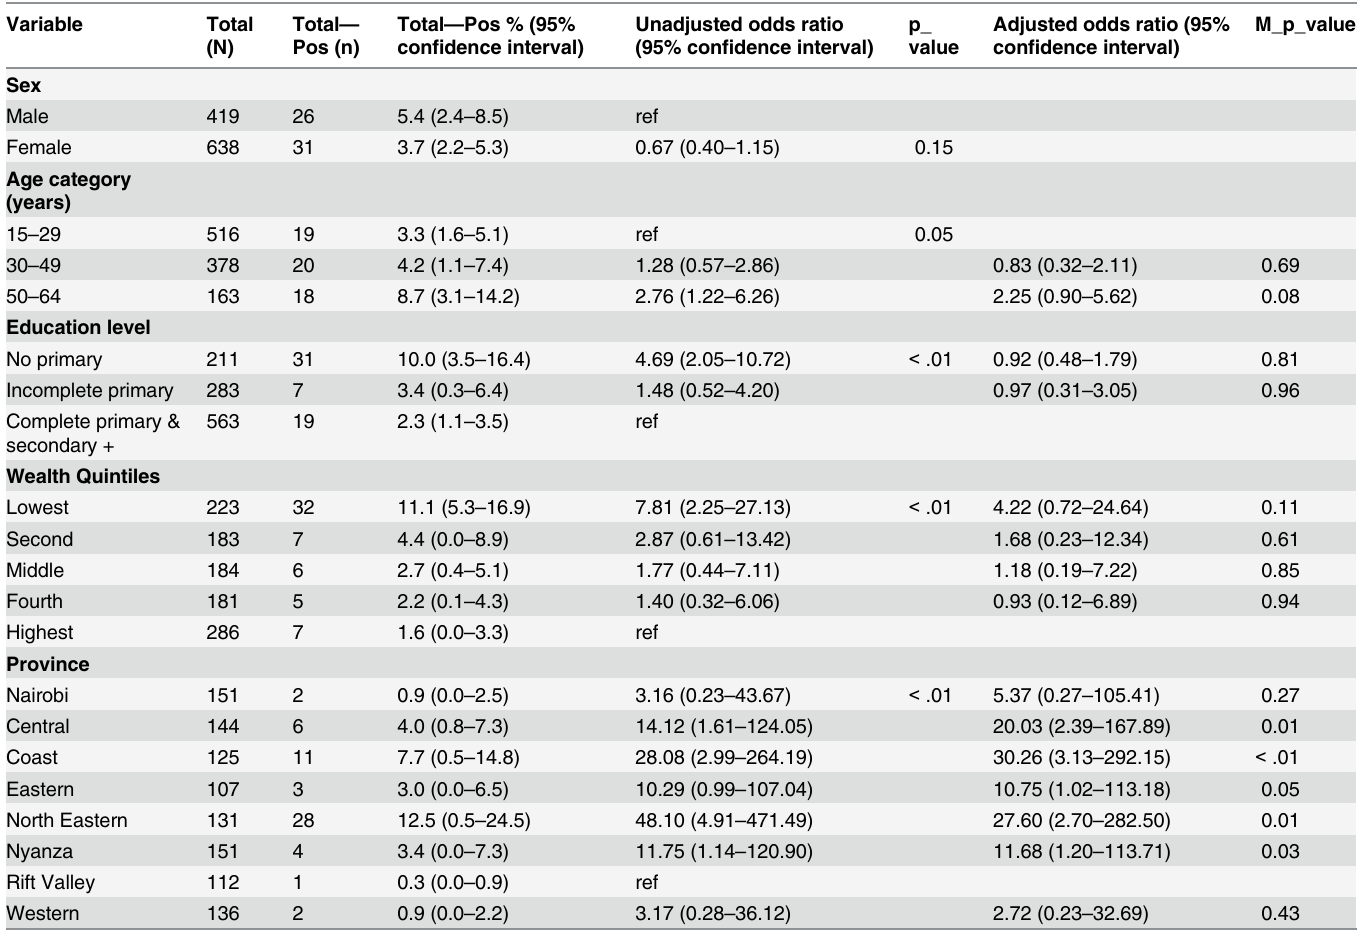
Table 3. Prevalence and factors associated with RVF virus among persons aged 15 – 64 years, Kenya,